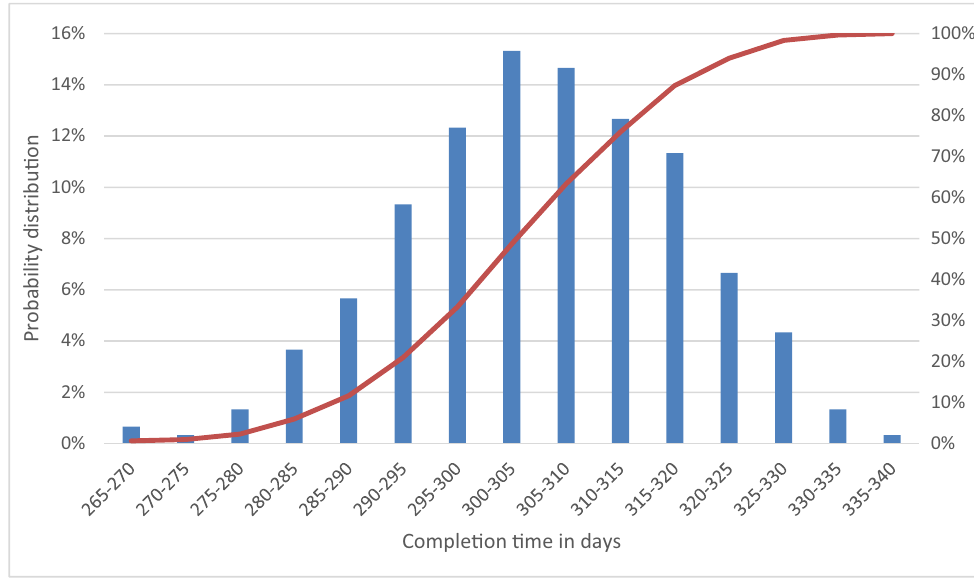
Figure 7: Probability distribution and distribution function for project completion time.